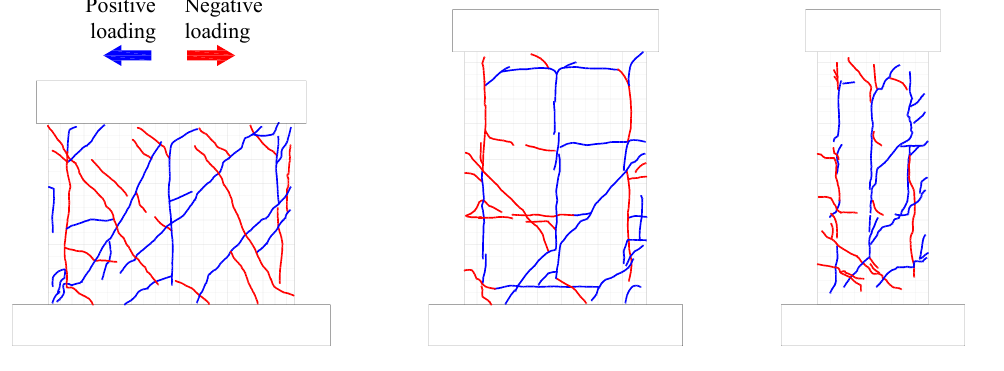
Figure 6. Crack patterns.